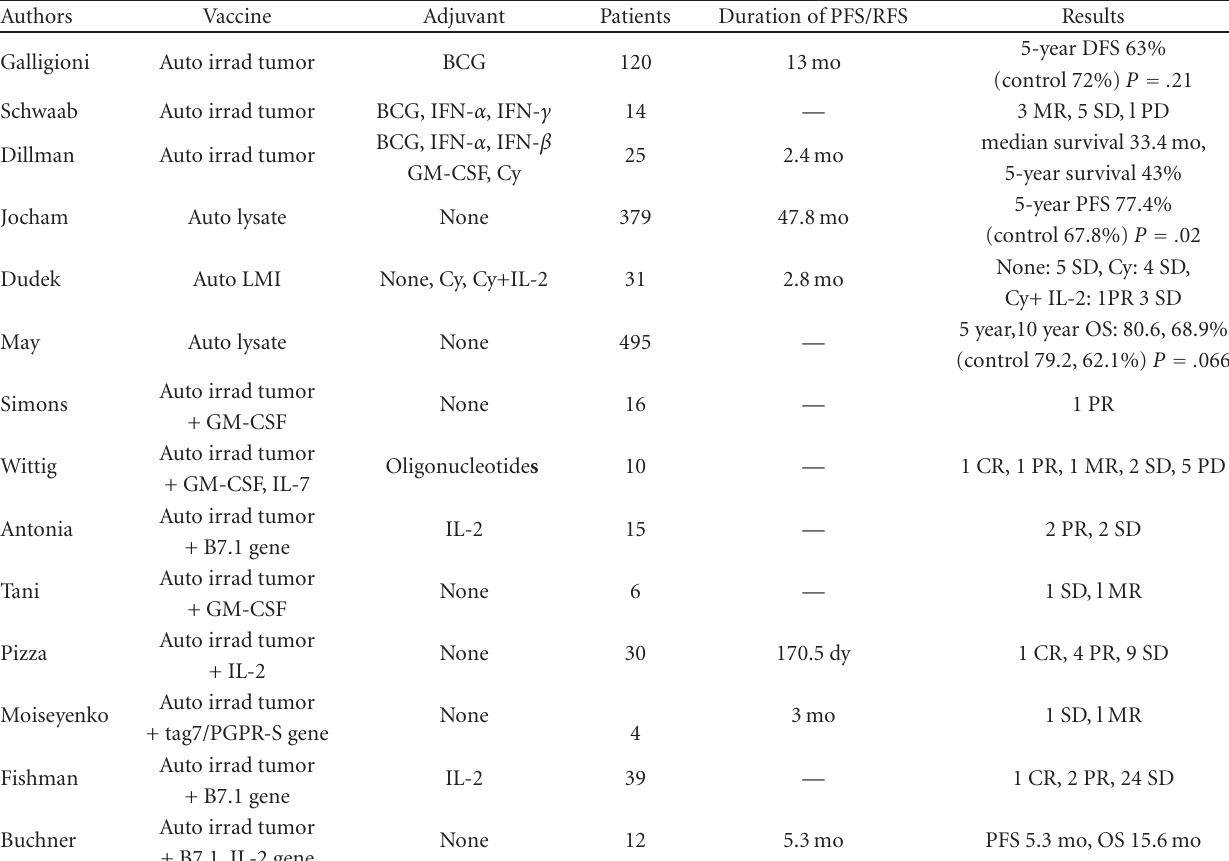
Table 1: Immunotherapy using inactivated tumor cells and a gene modified tumor vaccine